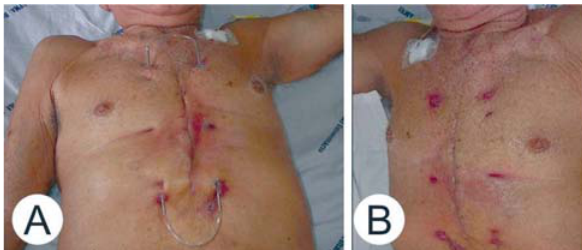
Fig. 5 - A: Removidos os pontos totais; B: aspecto